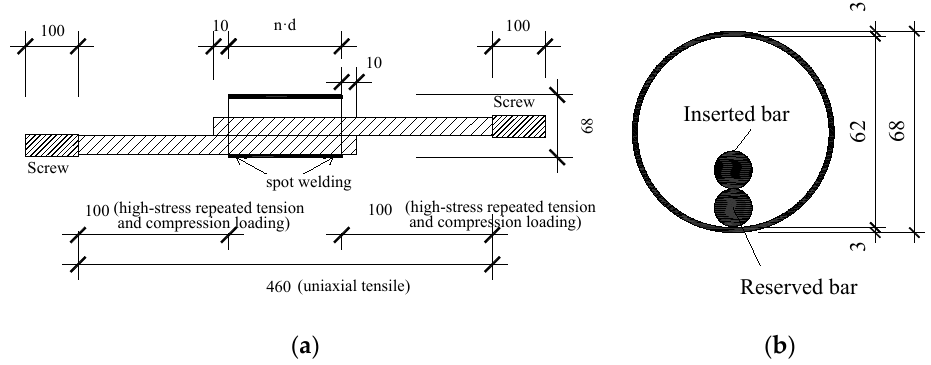
Figure 3. Schematic diagrams of specimens with different lapping lengths (unit: mm): ( a ) elevation of the specimen and ( b ) profile of the specimen.